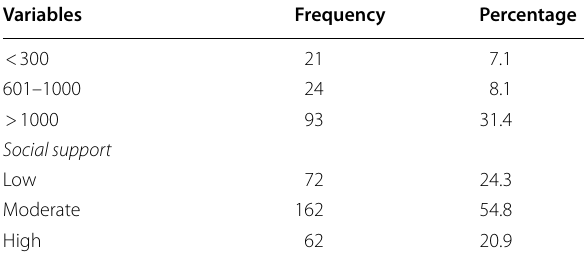
Table 1 Distribution of study subjects by socio-demographic factors peoples with epilepsy ( n 296) on follow-up at Ayder = comprehensive specialized hospital and Mekelle